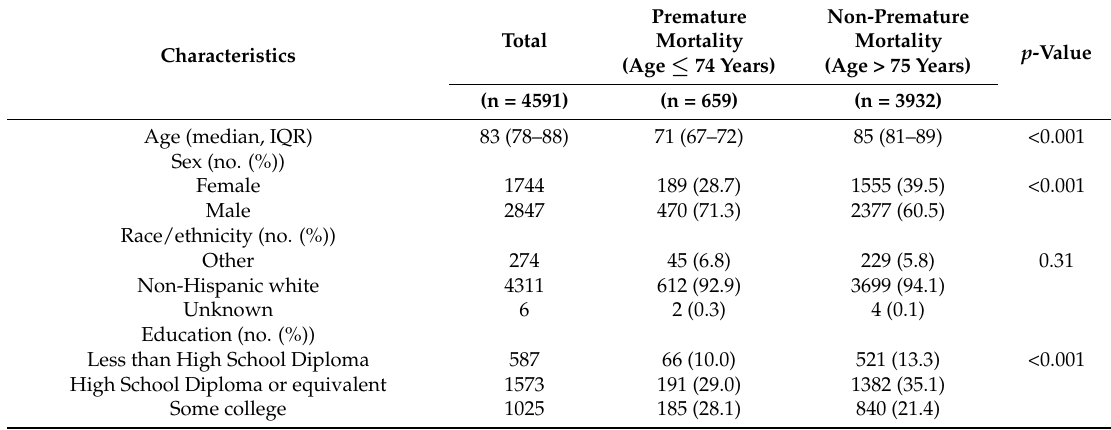
Table 1. Demographic characteristics of individuals who died from Parkinson’s disease from